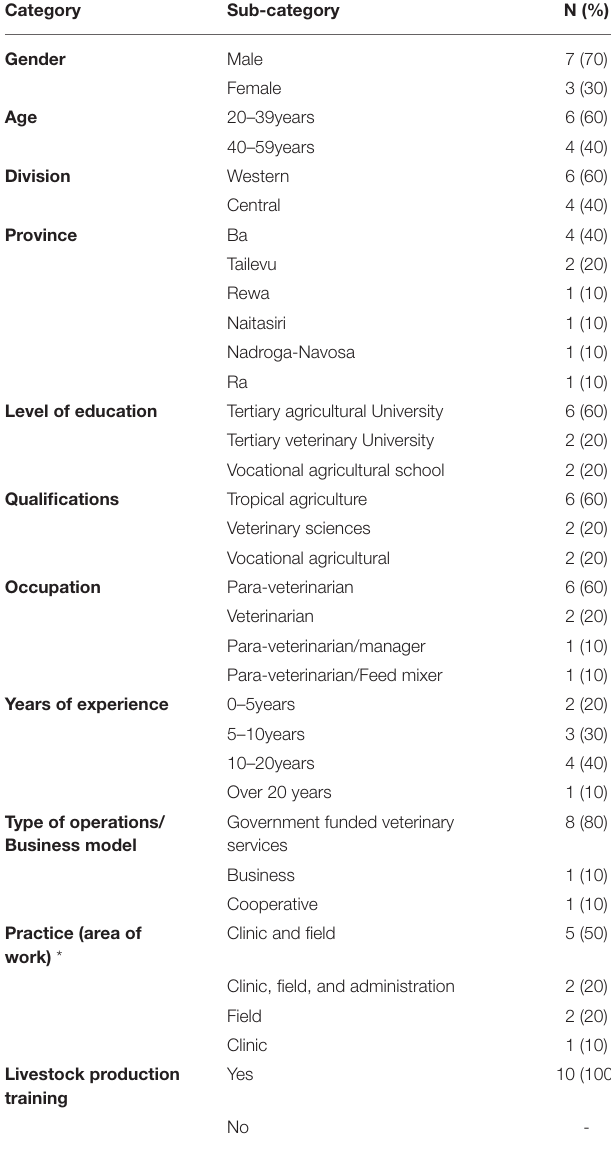
TABLE 1 | Demographic characteristics of the participants ( n =